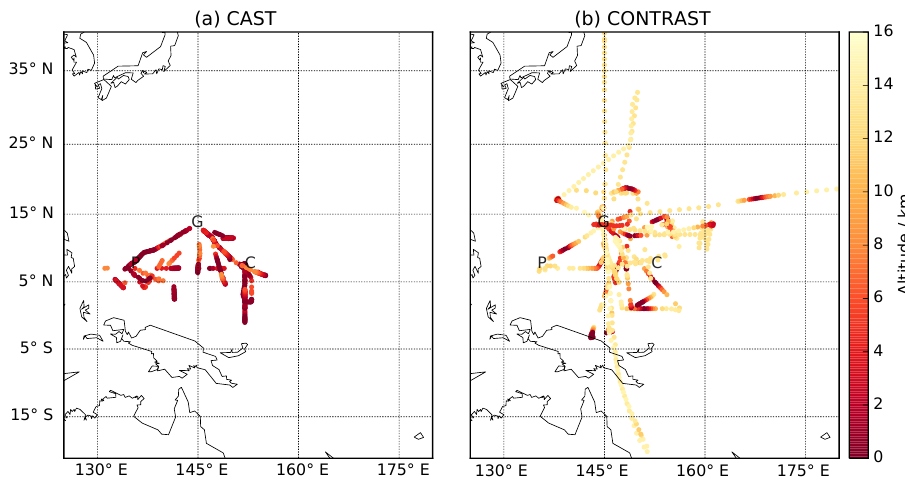
Figure 1. Measurement distribution of CHBr 3 and CH 2 Br 2 mole fractions from the CAST (a) and CONTRAST (b) aircraft campaigns as a function of altitude (km). Relevant island waypoints are shown inset: Guam (G), Palau (P), and Chuuk